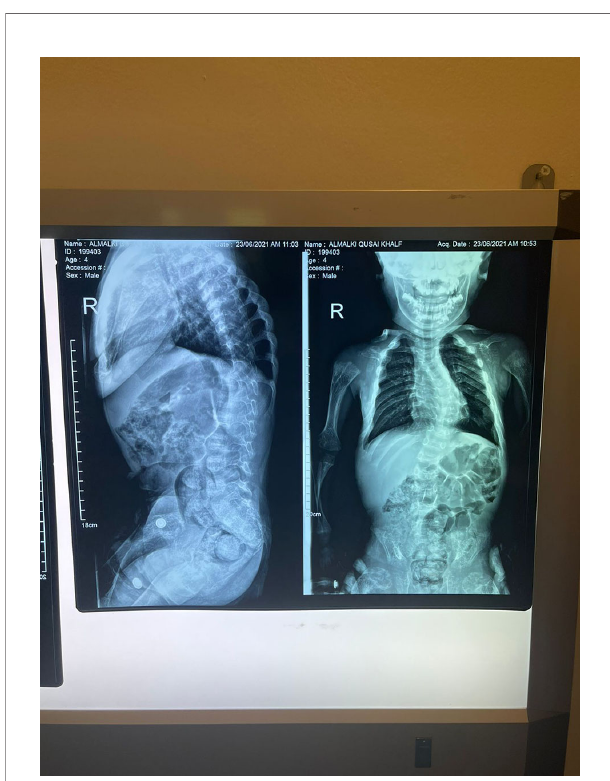
FIGURE 6 | Marked scoliotic deformity and marked osteopenic changes. The fi nal diagnosis by a genetic study showed a homozygous likely pathogenic variant was identi fi ed in exon 8 of the CYP27B1 gene: c.1375C>T. p.(R459C). Accordingly, this fi nding was consistent with the genetic diagnosis of autosomal recessive Vitamin D dependent rickets type 1A (VDDR1A). After six months of treatment with oral calcium (elemental 50mg/kg/d) and alfacalcidol (1 a -hydroxycolecalciferol) 50 ng/kg/d. He has minor radiological healed, but his clinical characteristics have not changed signi fi cantly as a result of severe bone abnormalities caused by a late diagnosis. Except for a high urine calcium creatinine ratio, his biochemical tests were normal ( Table 1 ), and the treatment was adjusted accordingly. The radiological features take much longer than the biochemistry to return to normal. Surgery could also be necessary later on after medical therapy has